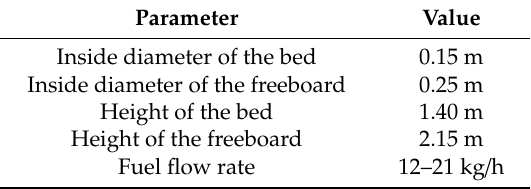
Table 3. Technical and operating parameters of the Campoy et al.’s [30] pilot